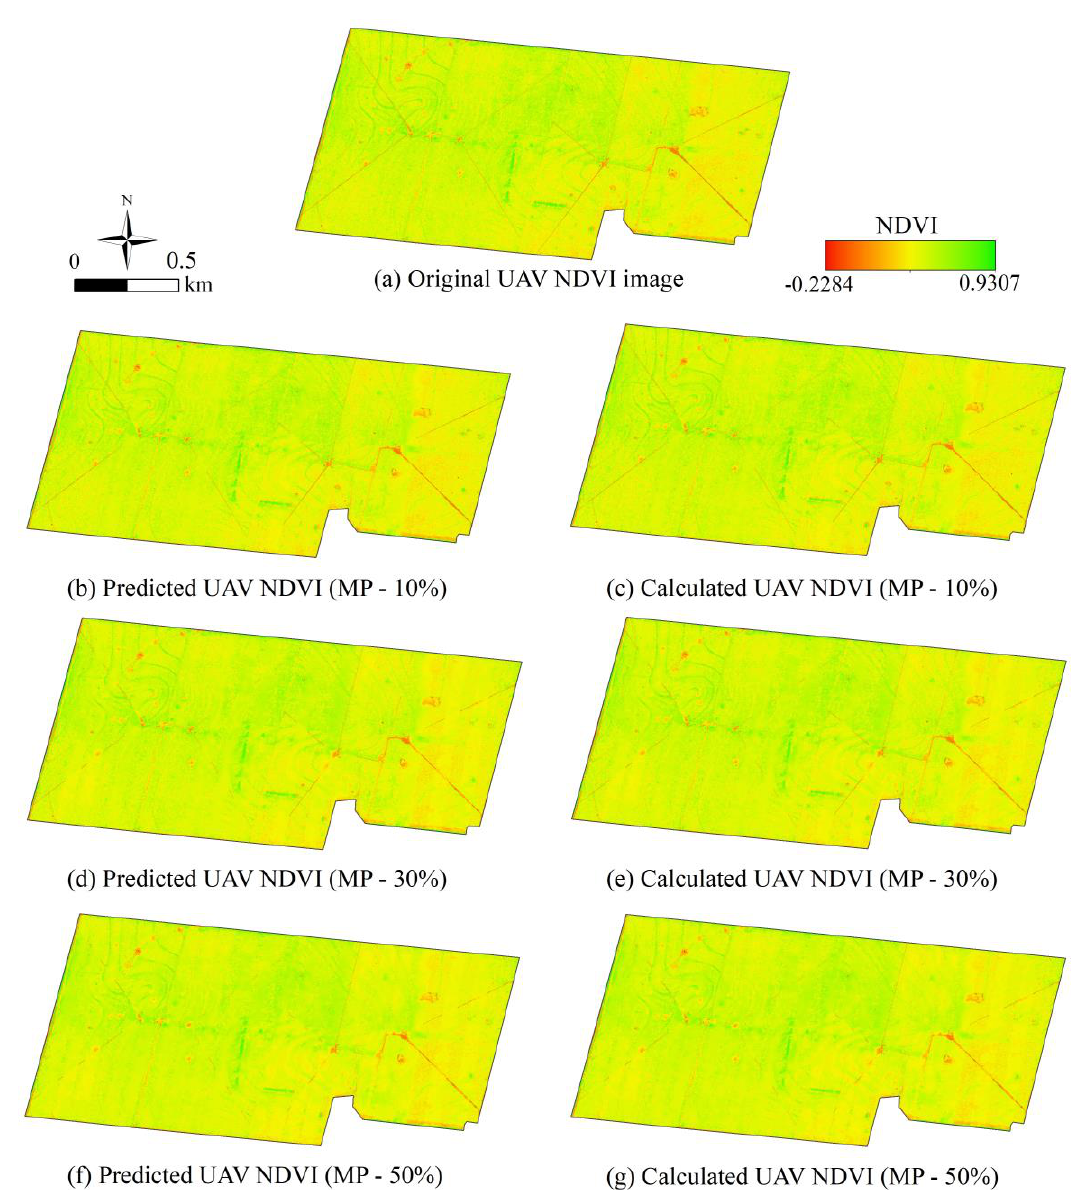
Figure 7. Original UAV NDVI image ( a ); predicted NDVI images with missing parts of 10% ( b ), 30% ( d ), and 50% ( f ); and the calculated NDVI images (based on the imputed R and NIR spectral bands) with missing parts of 10% ( c ), 30% ( e ), and 50% ( g ).